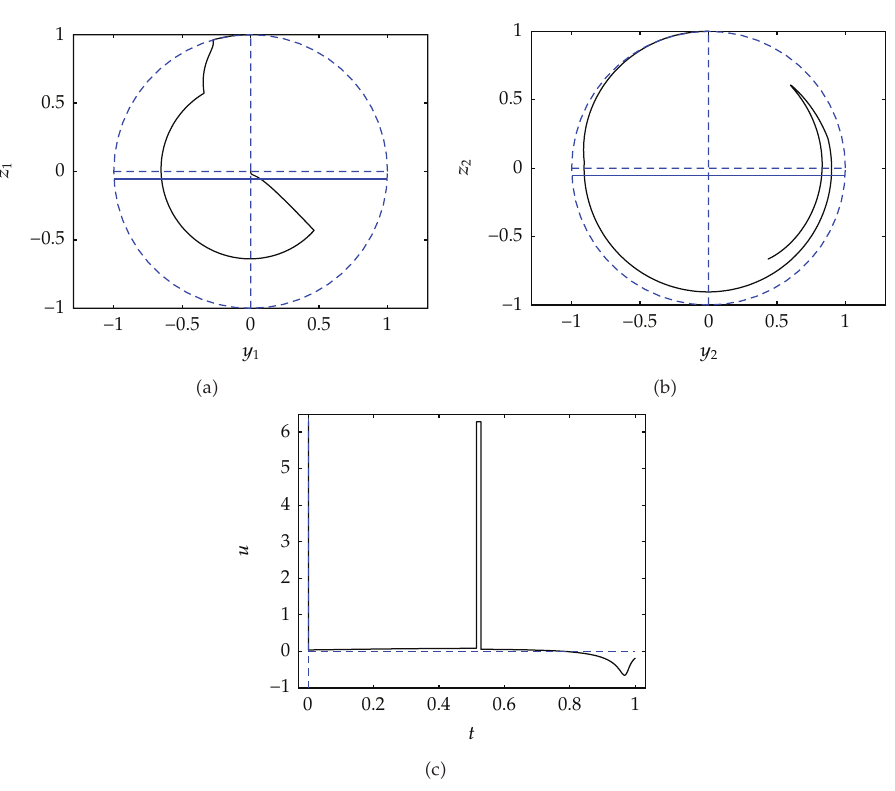
Figure 9: It is the same as Figure 8, but for a control field with a BSBS structure. Note the similarity of this result with the one of Figure